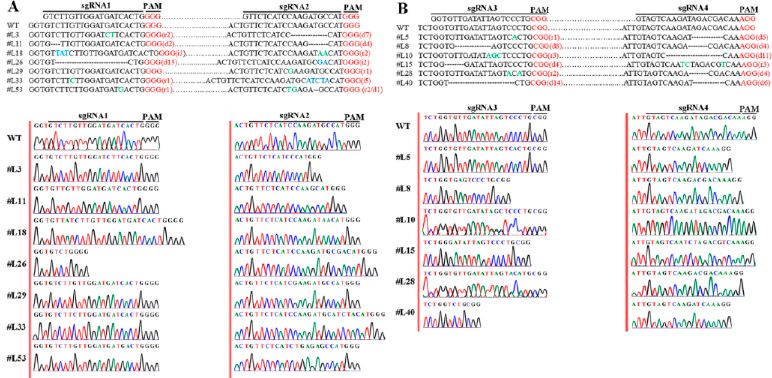
Figure 7. Identification of the mutation modes of KO- LpABCB21 ( A ) and KO- LpPILS7 ( B ) mutant lines. r / blue indicate replacements. i / green indicate insertions. d / - indicate deletions. Dots represent sequences between dual sgRNA. PAM represents NGG domains.